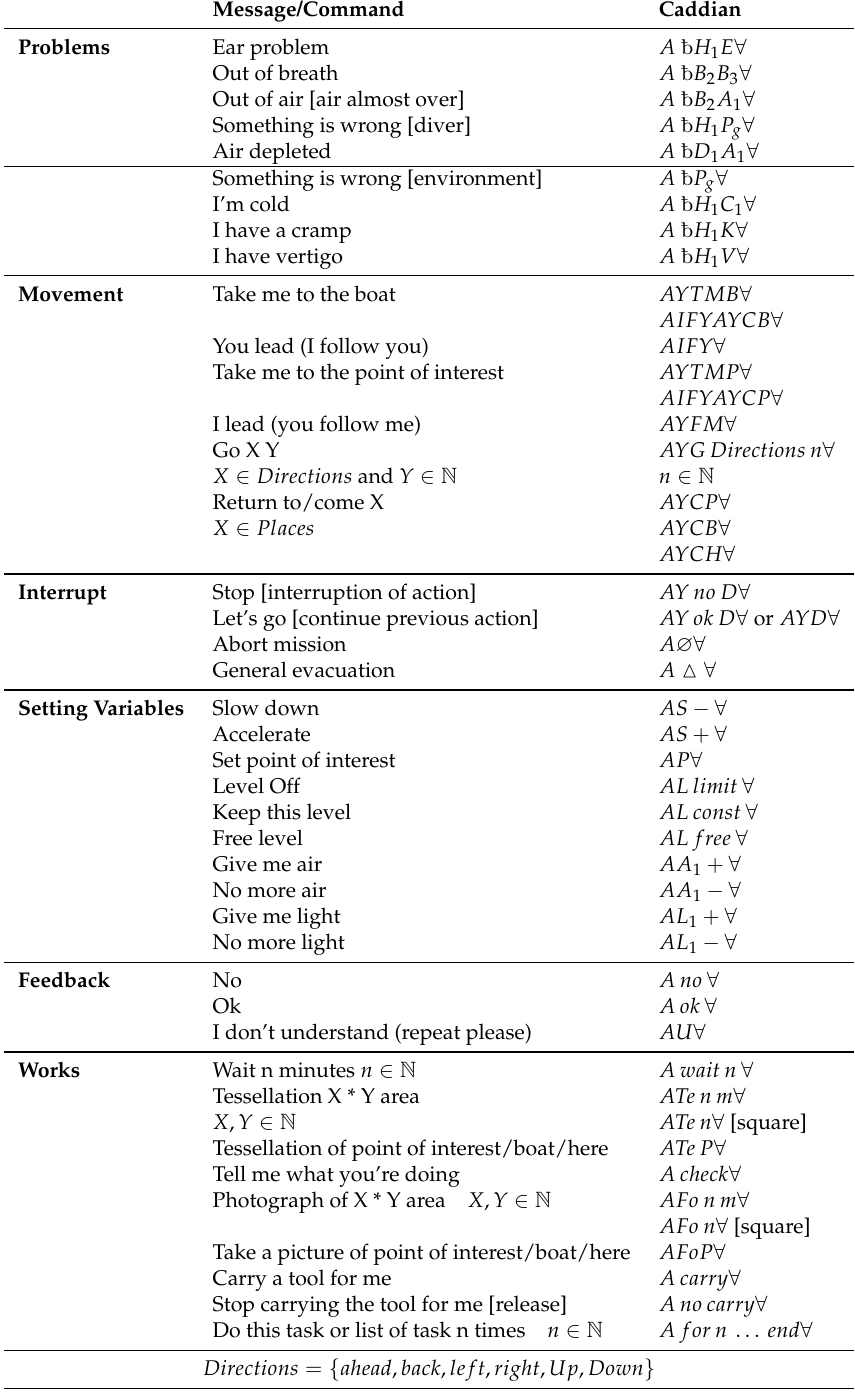
Table 2. Translation table as seen in